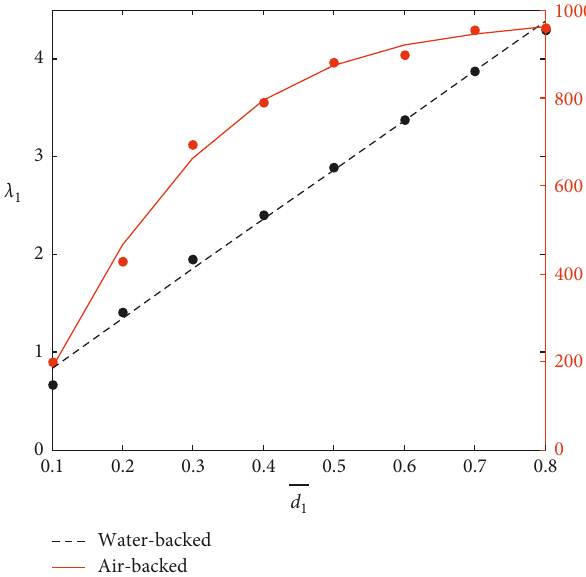
Figure 23: The reflection and transmission ratios for different outer shell thicknesses. The water-backed case is plotted in the left axis, and the air-backed case is plotted in the right